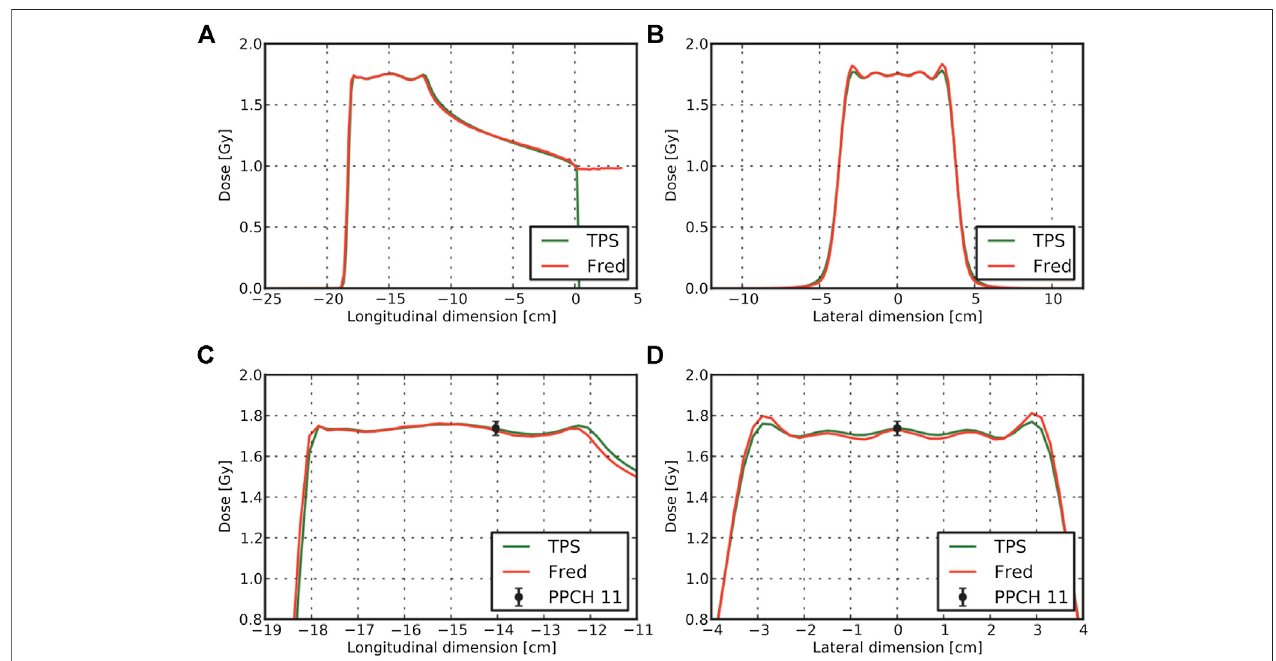
FIGURE10| Results forthecomparisonofFREDresultswithTPSadopted atCNAOforaSOBPcubeat15 cmdepthinwaterresultingfromatreatment planwith protons.TPSandFREDdoselineoutsthroughthecubecenterareshowninpanels (A) and (B) .Enlargedversionofthepro fi lestogetherwiththemeasureddoselevelfor a pinpoint ionization chamber is visible in panels (C) and (D)